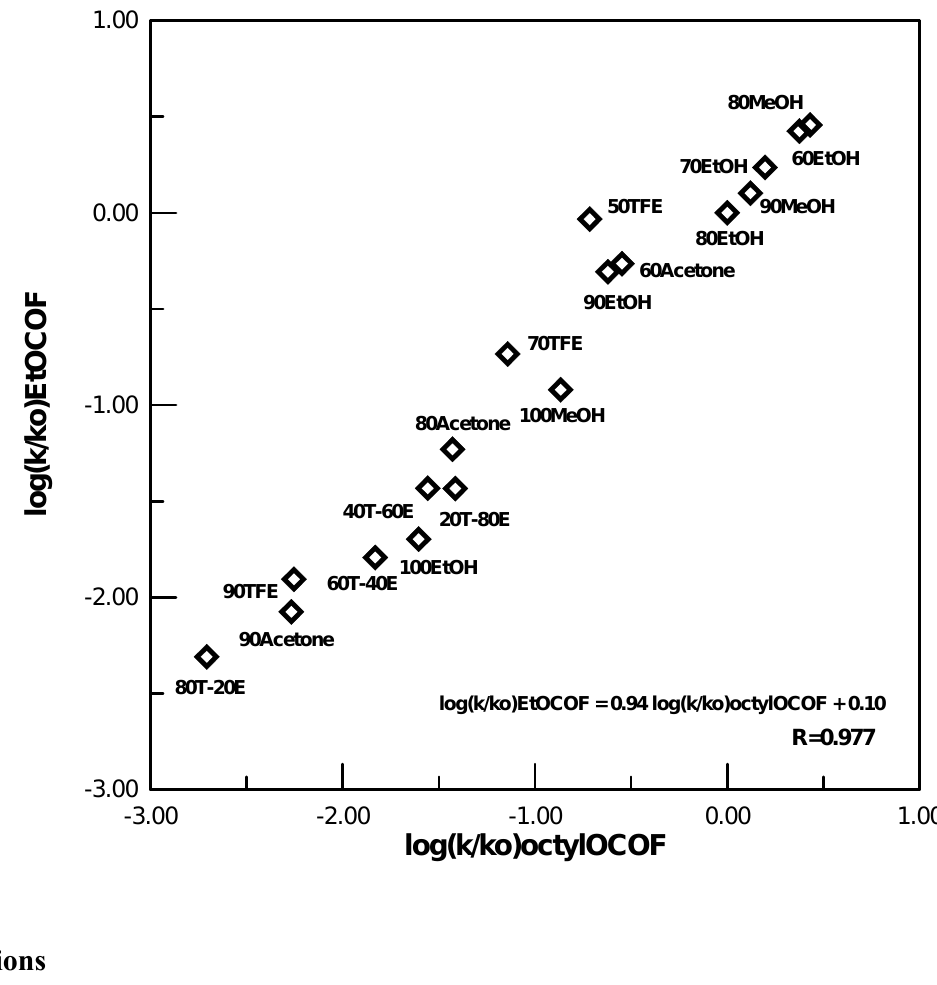
Figure 2. Plot of log ( k/k solvolyses of n -octyl fluoroformate at 24.2 °